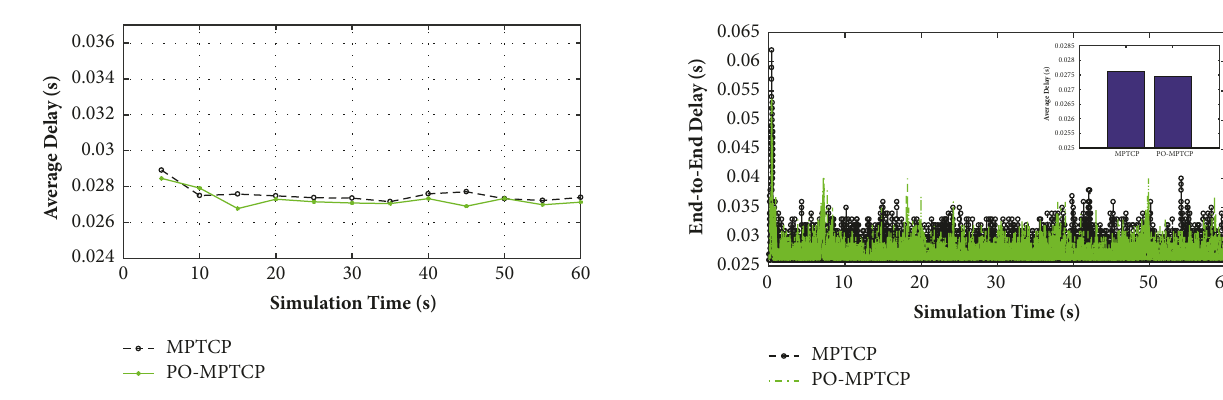
Figure 5: Comparison of delay. Figure 6: Comparison of end-to-end